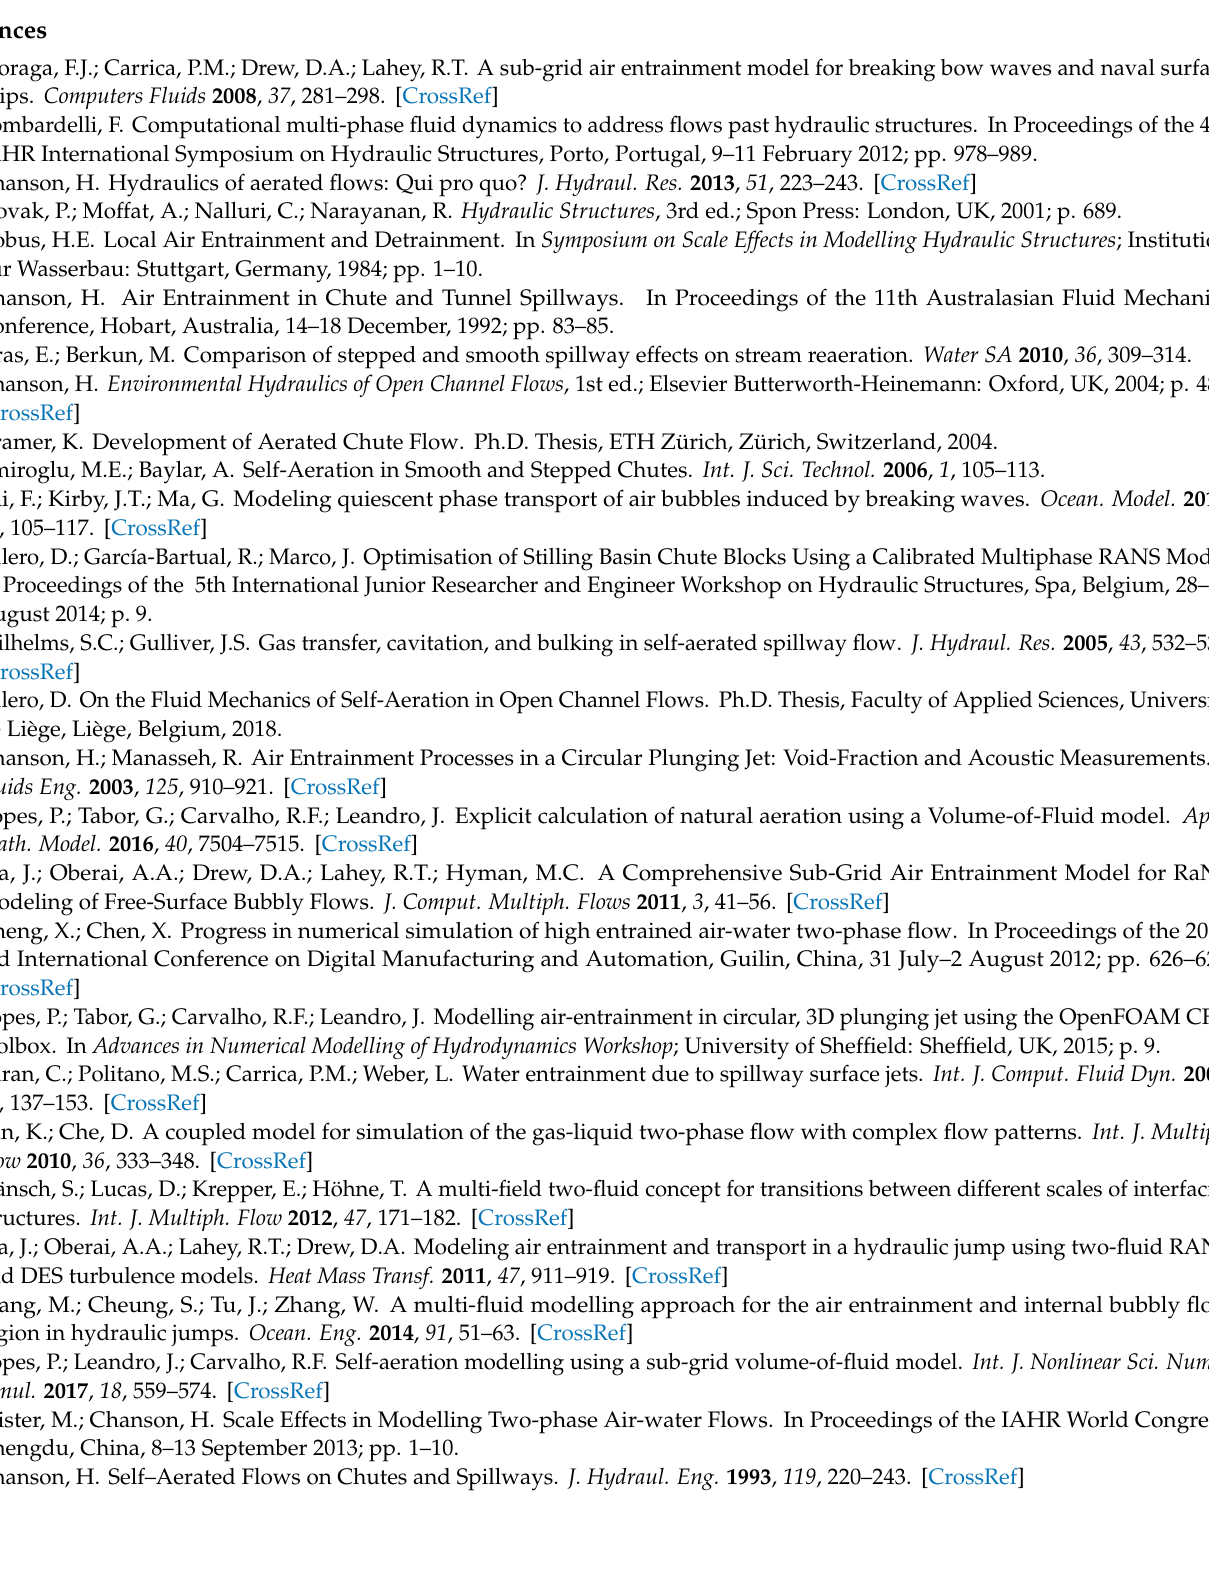
3. Finally, a domain mask (A4) is found, which identifies the single layer of cells where bubble entrainment takes